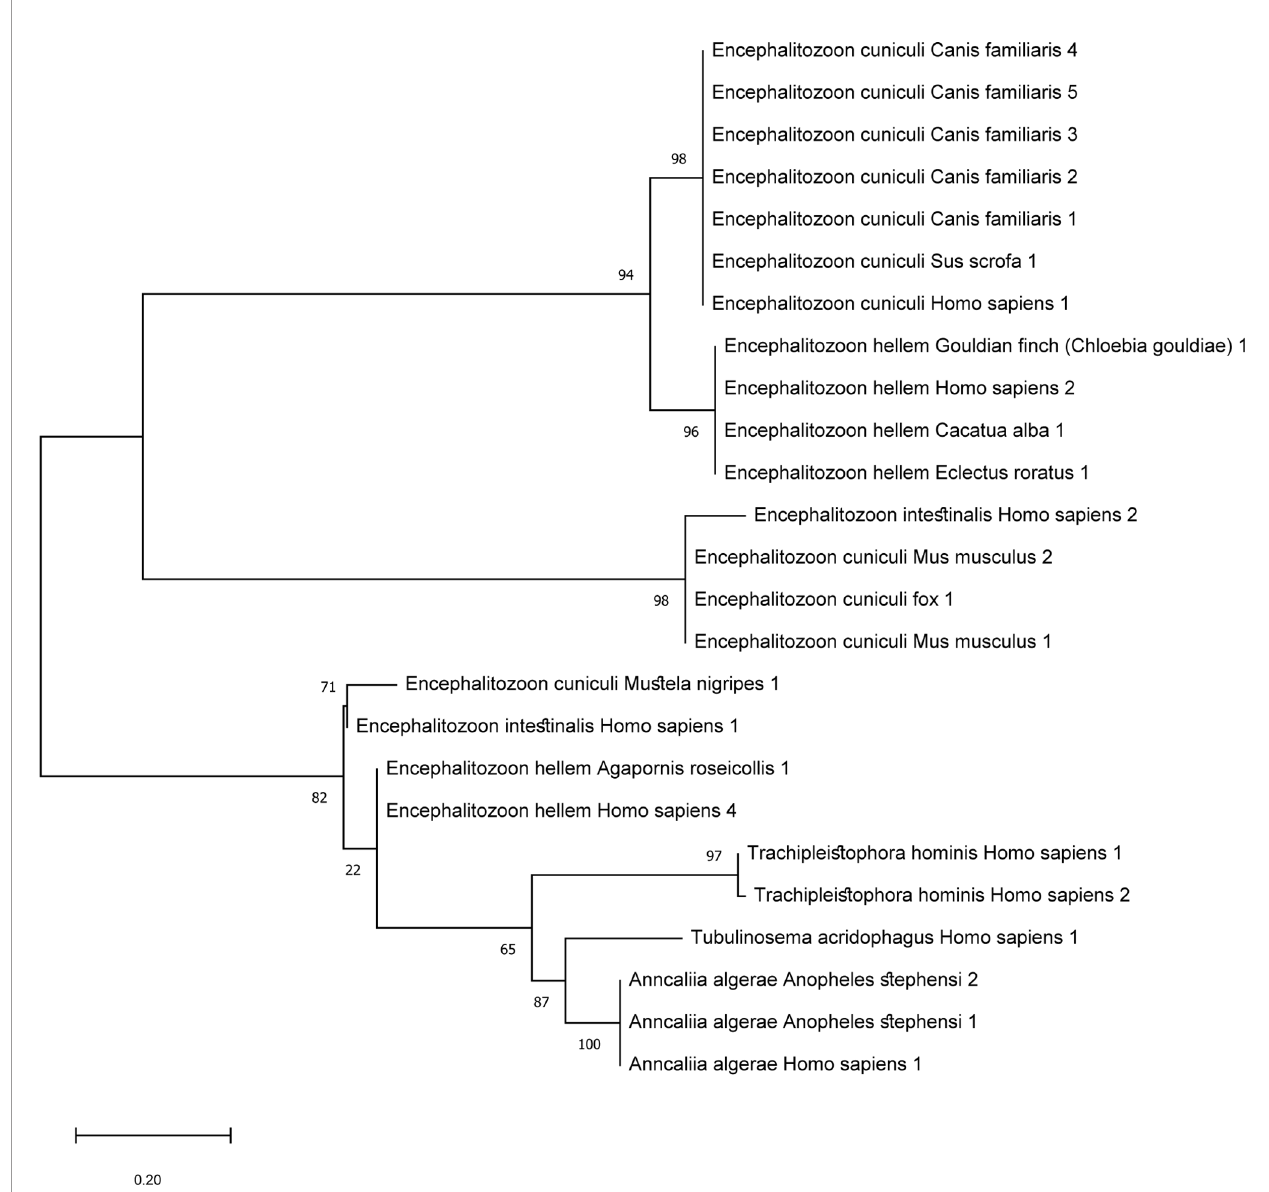
FIGURE 3 | Maximum likelihood tree of microsporidia that cause disseminated disease in humans and sequences of the same species of other hosts were included. ML tree was constructed in Mega software version X using Kimura-2 parameter model. The sequences included were based on microsporidia species with reports of causing disseminated diseases in humans. Other nucleotide sequences detected in other organisms were included to fi nd links of zoonosis. T. hominis species are closely related to A. algerae which is congruent with previous